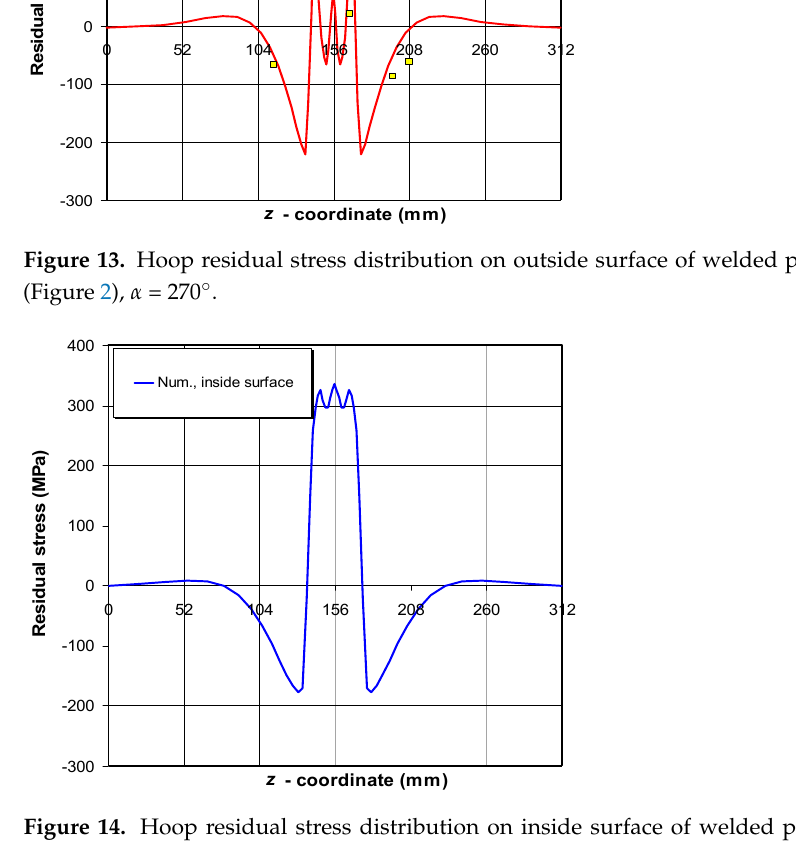
Figure 14. Hoop residual stress distribution on inside surface of welded pipes along line z 1- z 2 (Figure 2), α = 270°.